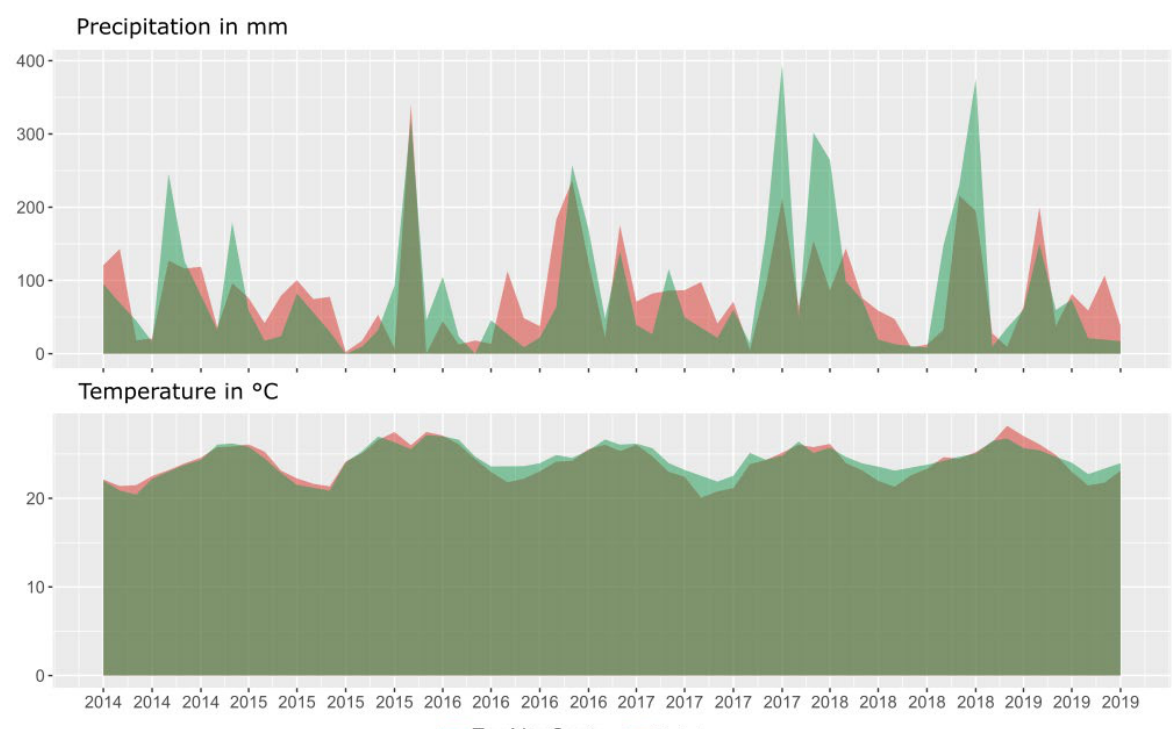
Figure 3. Information on monthly averages of total precipitation and the average temperature of climate data from two environments, Bahia and Esp í rito Santo, in the period between the implemen- tation of the experiment and the last evaluated coffee crop ( C. canephora